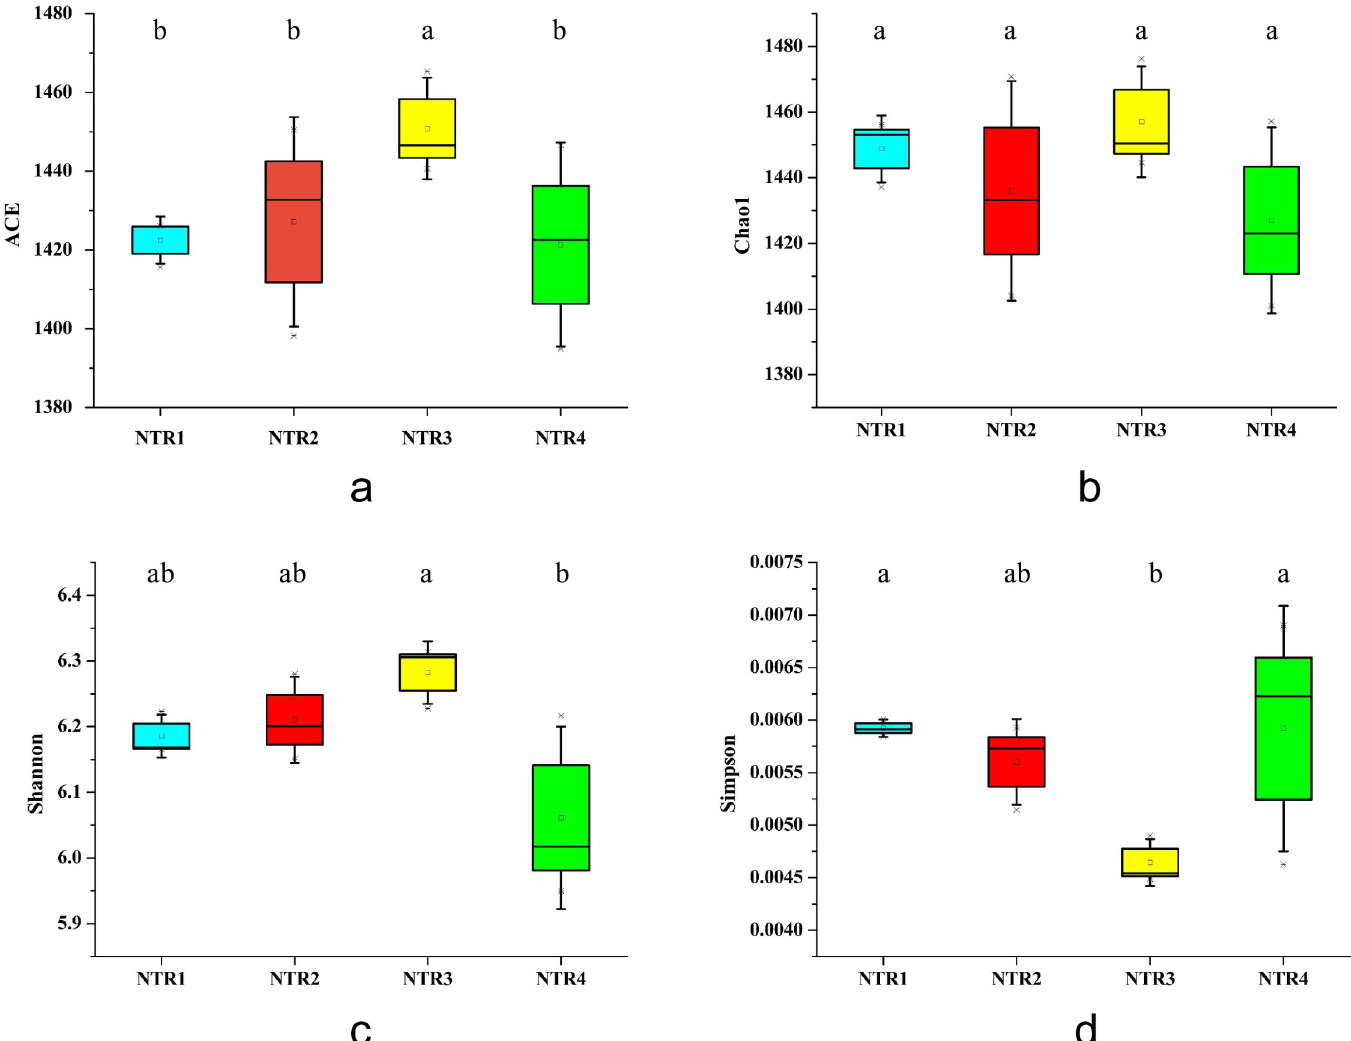
Fig 2. The diversity and richness of soil bacterial according to the Chao1 (a), ACE (b), Shannon (c), and Simpson (d) indexes after different no tillage and crop residue mulching treatments . NTR1, no tillage and all crop residue removed; NTR2, no tillage and 30% crop residue mulching; NTR3, no tillage and 60% crop residue mulching; NTR4, no tillage and all crop residue mulching. Boxplots with different letters above the boxes denote significantly different means (P <